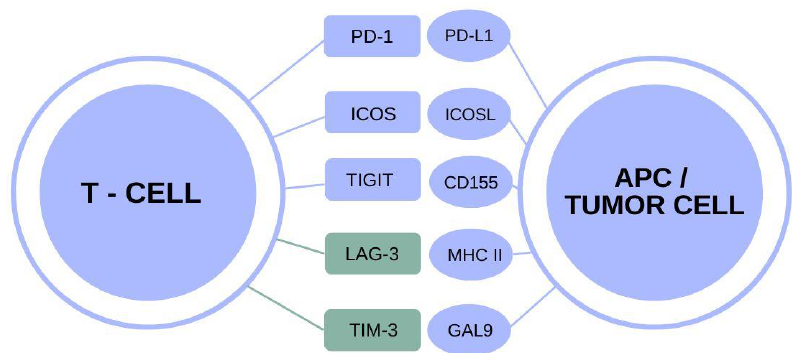
Figure 1. Immune checkpoints with indication of described molecules